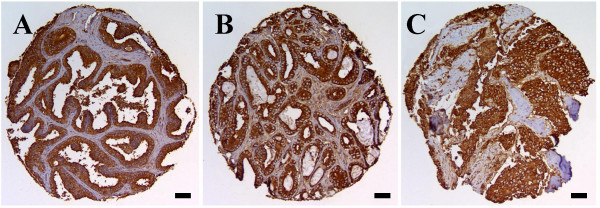
Human prostate tissue samples stained with CD164. High-density tissue micro arrays of human CaP tumors were immunostained for CD164, AR and PSA as described in the methods. Immunostaining intensity was scored by a genito-urinary pathologist: as absent (1), weak (2), moderate (3) or strong (4). Scoring was performed blindly using a telepathology system without knowledge of overall the tumor grade, tumor size or clinical outcome [30]. Representative staining of CD164 staining for (A) benign prostate hyperplasia (B) localized prostate cancer (C) metastatic prostate cancer to bone marrow. Correlation of CD164 staining with prostate specific antigen (PSA) staining intensity (D), androgen receptor (E) and tissue type (F). The data demonstrate that CD164 staining intensity increases with increasing tumor grade.